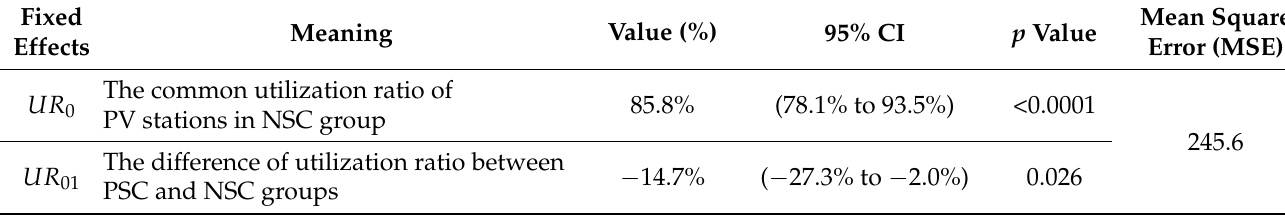
Table 3. The fixed-effects results of the average model based on the MEM in Equation (5).